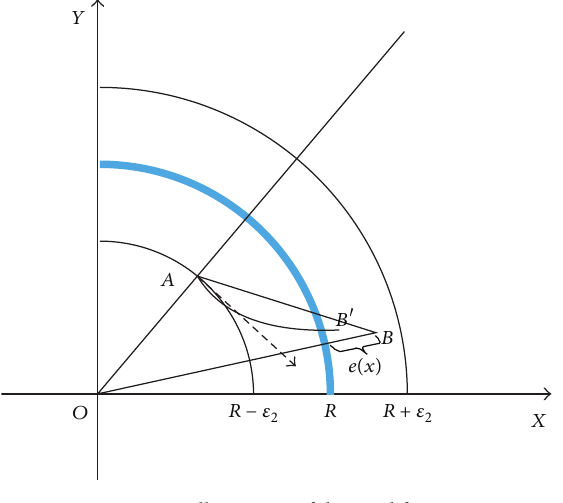
Figure 6: Illustration of the need for 𝜑 4